Question: What does this figure show? Answer in one sentence.
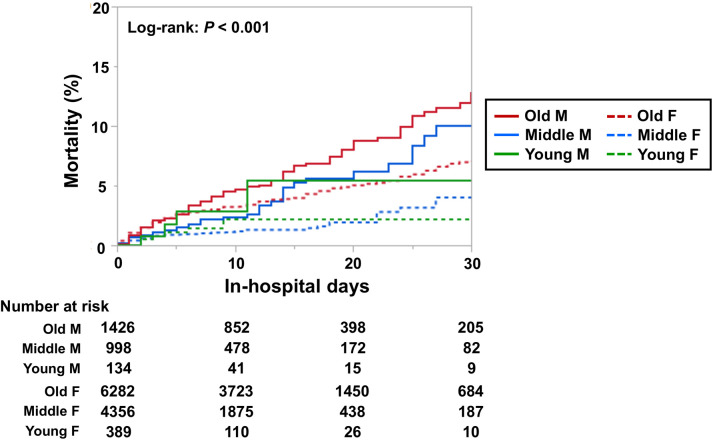
Answer: Kaplan-Meier curves for 30-day in-hospital mortality stratified by age and sex. Kaplan–Meier estimates of 30-day in-hospital mortality are presented for six groups defined by age (Young: ≤50 years, Middle: 51–74 years, Old: ≥75 years) and sex. F, female; M, male.